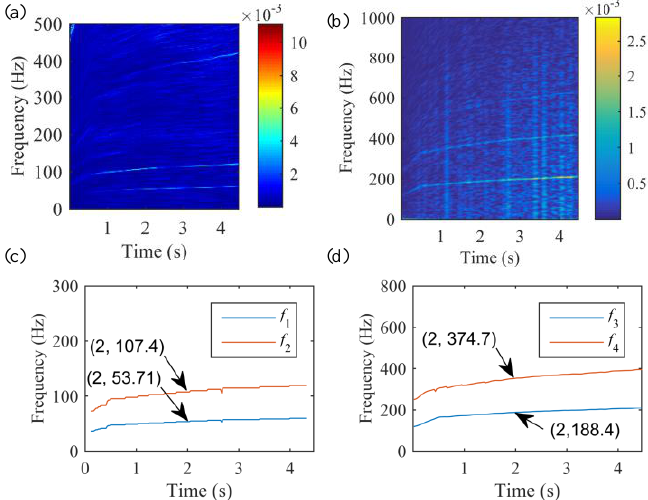
Figure 9. Outer race fault case: illustration of the constructed frequencies of bases of FMLT. Appl. Sci. 2019 , 9 , x FOR PEER REVIEW